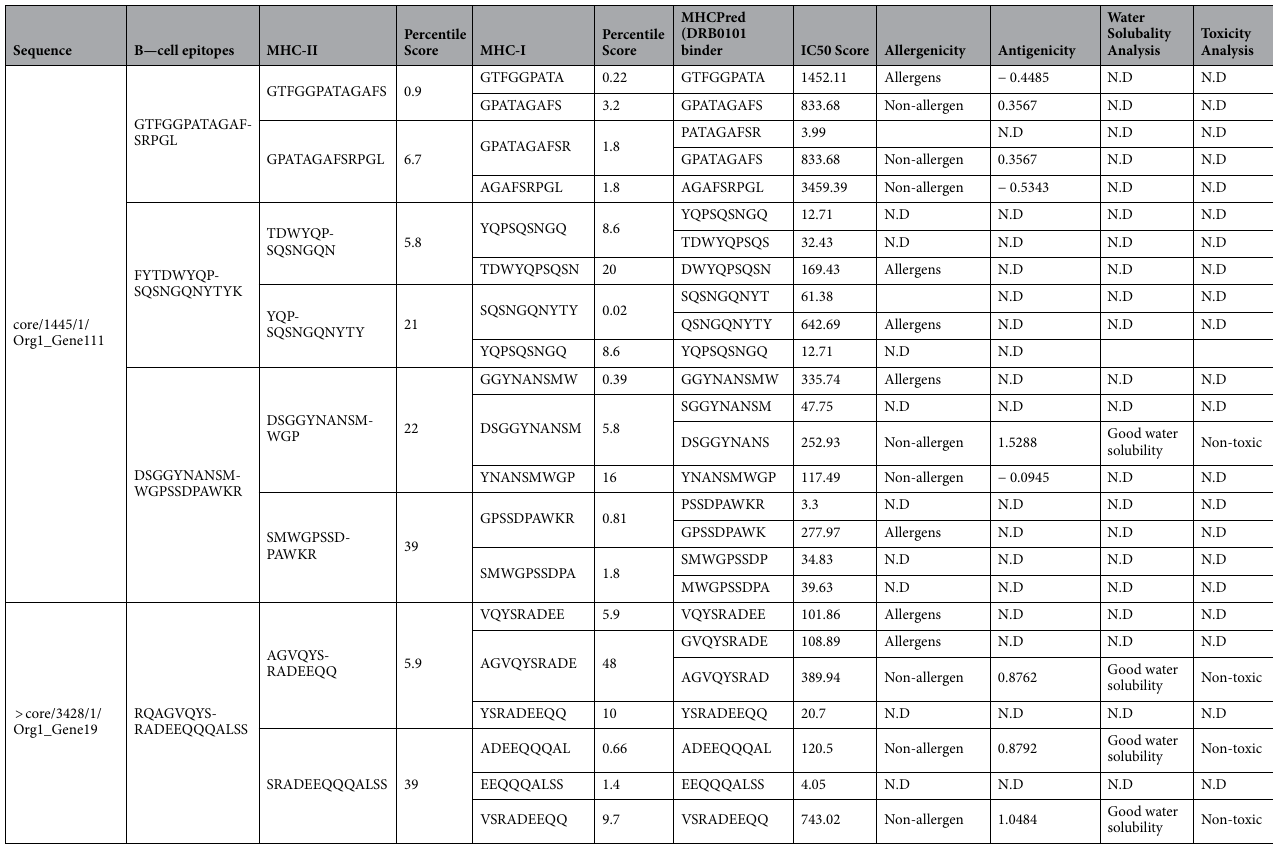
Table 2. Epitope mapping analysis for potential vaccine candidates. If a epitope fail in one of the given analysis that epitope was not forwarded to next analysis. N.D not